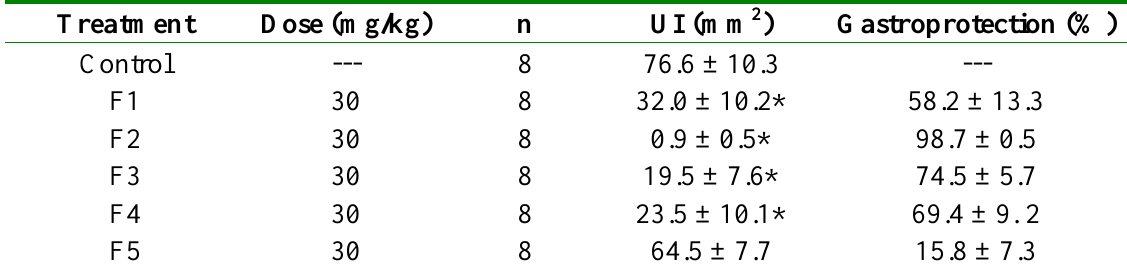
Table 2. Gastroprotective effect of the fractions of dichloromethane extract on ethanol- induced ulceration in